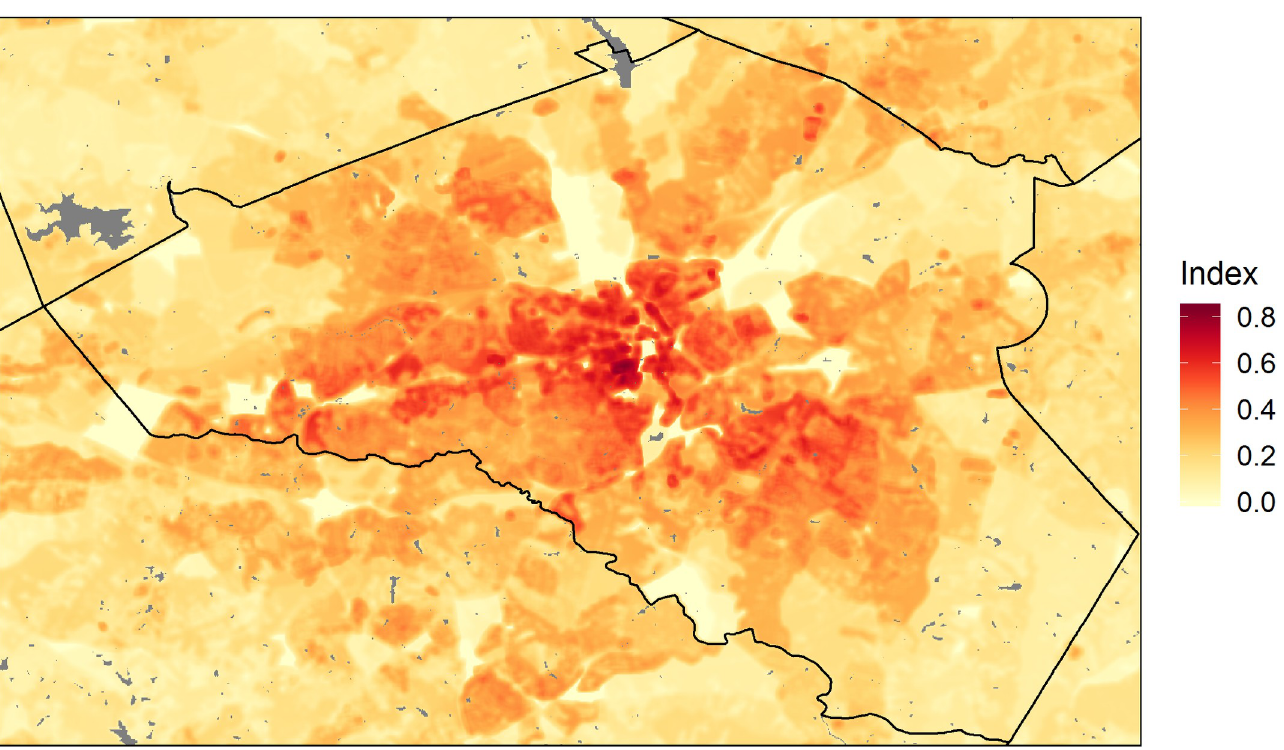
Fig 9. Map of a vulnerability index for dengue transmission in Athens-Clarke County, GA. The index was based on the standardized VC(T) for June-October 2018 and standardized, log-transformed human population density data from the U.S. Census. Gray patches represent water bodies. The map was produced using R version